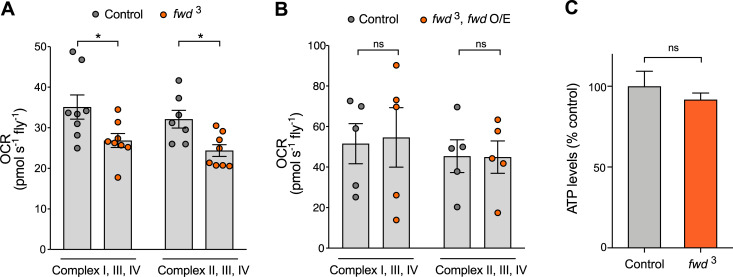
Loss of fwd inhibits mitochondrial respiration.(A, B) Mitochondrial respiration analysis by oxygen consumption rate (OCR) in control and fwd mutant adults, and fwd mutant ubiquitously re-expressing fwd. (C) ATP levels in control and fwd mutant adults. Charts show mean ± SEM. Significance was analysed by paired (A, B) or unpaired (C) t-test. * P<0.05; ns, non-significant. Full genotypes are given in S1 Table.